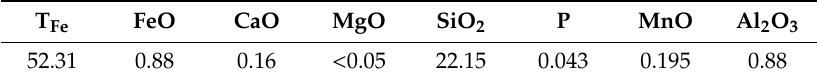
Table 1. Chemical composition of Brazilian mineral powder (mass %).